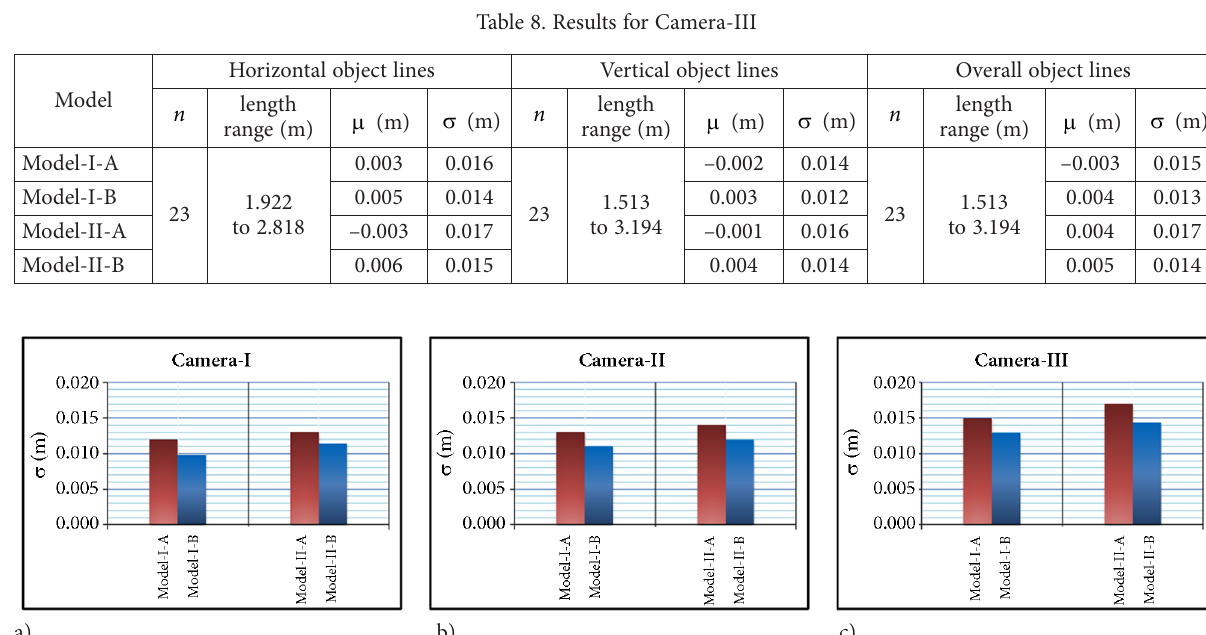
Figure 14. Overall lines’ standard deviations for all models: a – Camera-I; b – Camera-II; c –